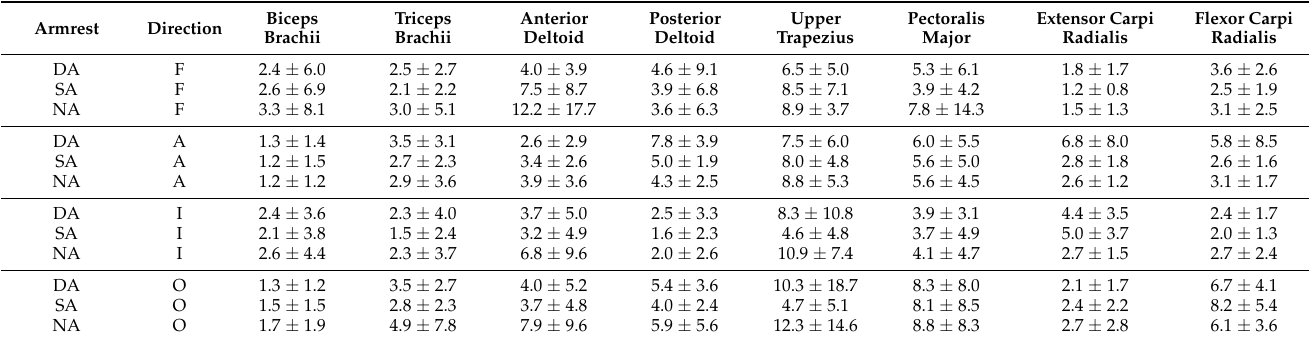
Table 4. Integrated EMG data for each armrest condition (DA = dynamic armrest, SA = station- ary armrest, and NA = no armrest) and movement direction (F = fore, A = aft, I = inward, and O = outward). Integrated EMG data are normalized to task specific reference voluntary contractions, expressed as mean ± standard deviation (%tMVC). N = 15, except for the upper trapezius data where N = 14.